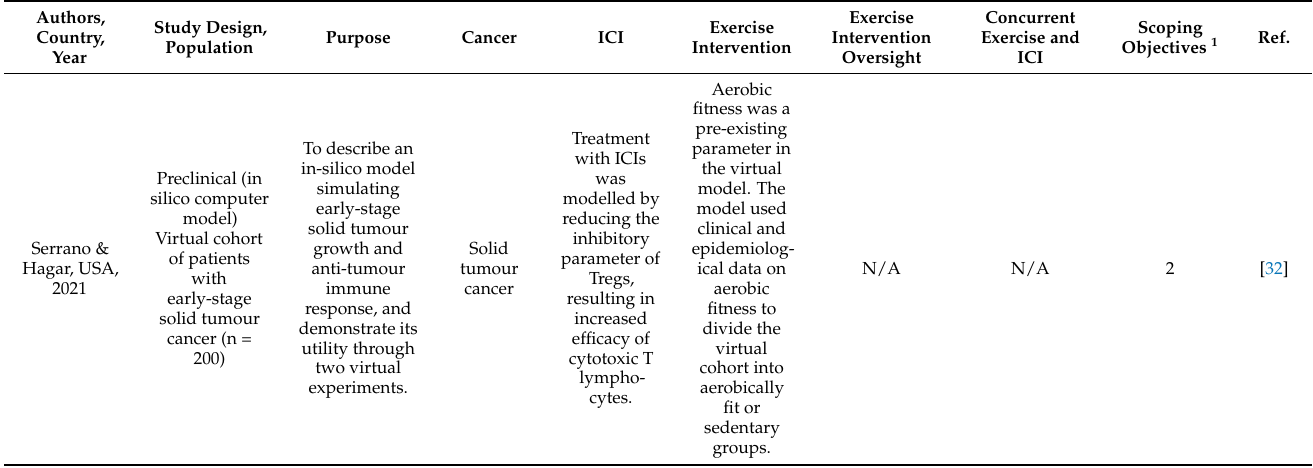
Figure 2. Flowchart of study selection. Adapted using the ‘PRISMA 2020 flow diagram for new systematic reviews which included searches of databases’ template [31]. † Different records relating to the same study (confirmed by comparison of authors, methodology and reported results) e.g., abstracts from different conferences relating to the same study. Where available, the duplicate record containing a full-text article was included. ‡ Two studies were abstract-only. [ICIs, immune checkpoint inhibitors]. Table 2. Characteristics of eligible studies (n =